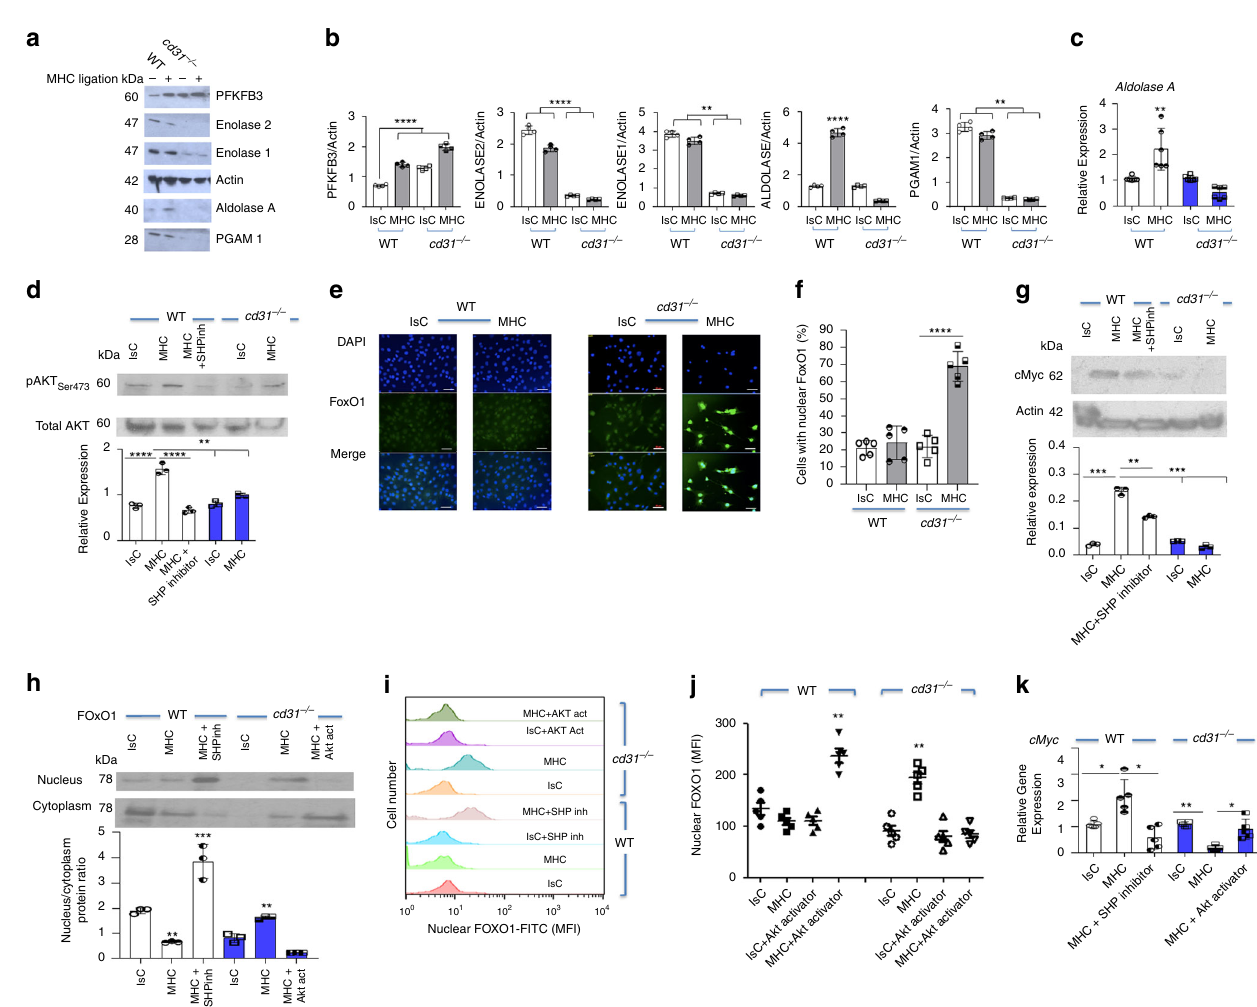
Fig. 6 CD31 signals induce transcription of glycolytic enzymes via inhibition of FoxO1 activity. WT and cd31 − / − EC were stimulated by MHC antibody- ligation or treated with an isotype-matched control and secondary antibody (4 h). a , b Expression of the indicated enzymes was analyzed by immunoblotting and quanti fi ed by densitometry. N = 3 independent experiments. c Expression of aldolase A mRNA in WT and CD31 de fi cient EC was determined by RT-PCR 2 h after stimulation. N = 3 independent experiments. Data are mean ± SD. One-way Anova with Tuckey post-hoc test. b PFKFB3 WT IsC vs WT MHC **** p < 0.0001, PFKFB3 WT IsC vs cd31 − / − MHC **** p < 0.0001, PFKFB3 WT MHC vs cd31 − / − MHC **** p < 0.0001, Enolase2 WT